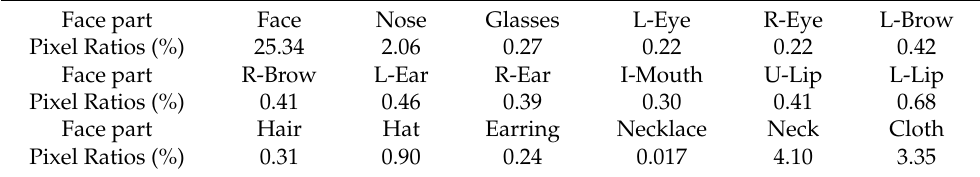
Table 5. Pixel ratios of face-part categories on the CelebAMask-HQ train set in terms of F1